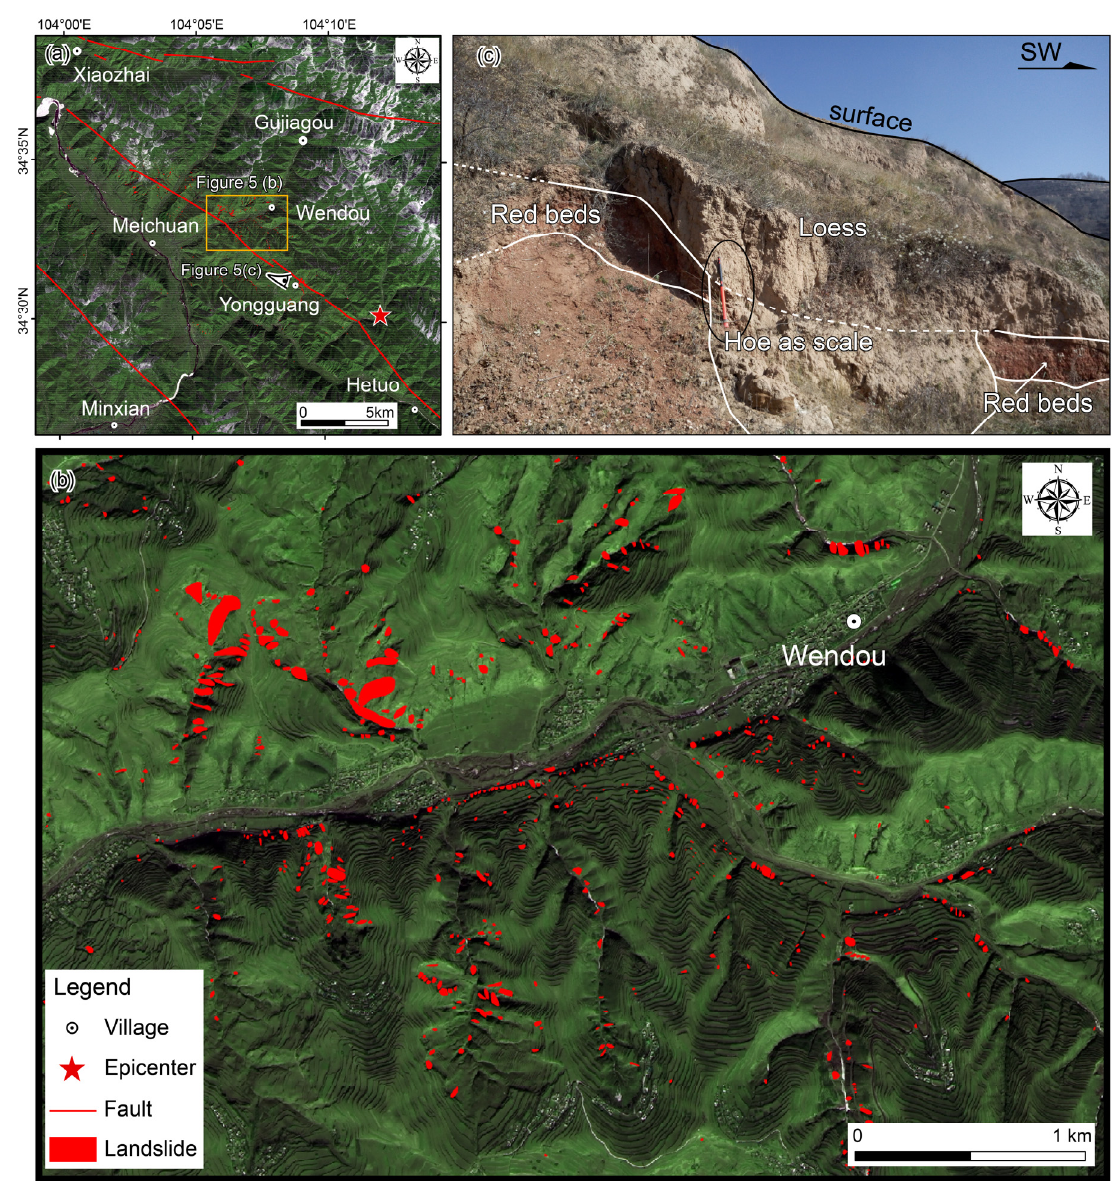
Figure 5. Inventory map of the earthquake-induced landslide in Minxian. ( a ) Landslide map; ( b ) Landslides around Wendou; ( c ) Typical outcrops developed near the Yongguang village: the tertiary red beds covered by thick loess.